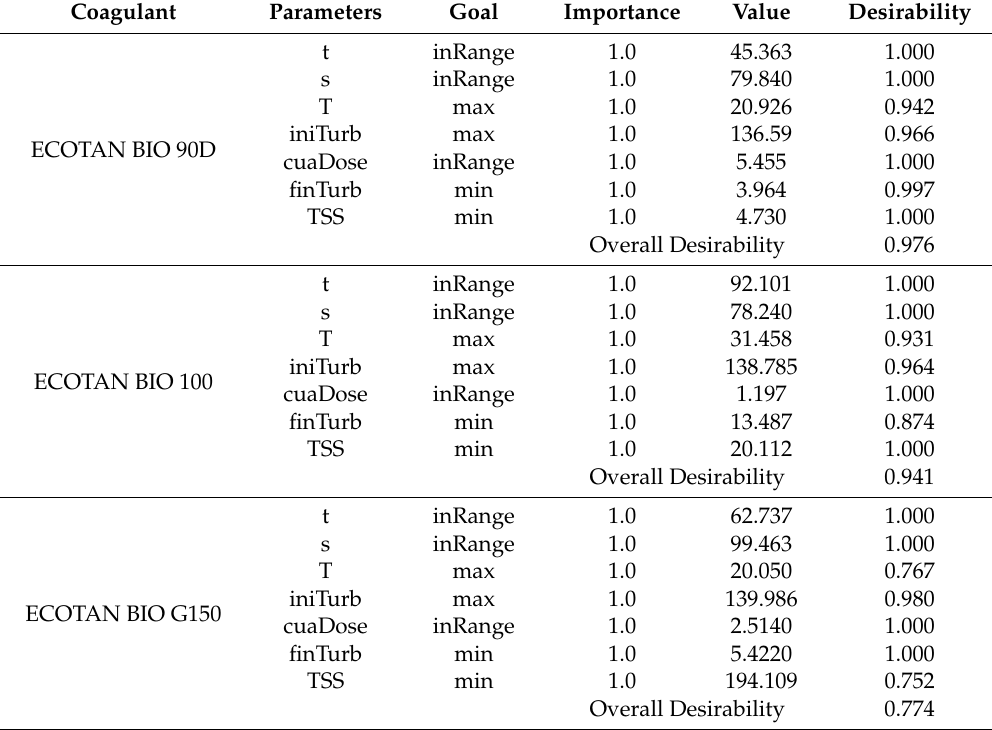
Table 18. The fifth clarification optimization scenario: the turbidity and TSS are minimized when the sample water is turbid and